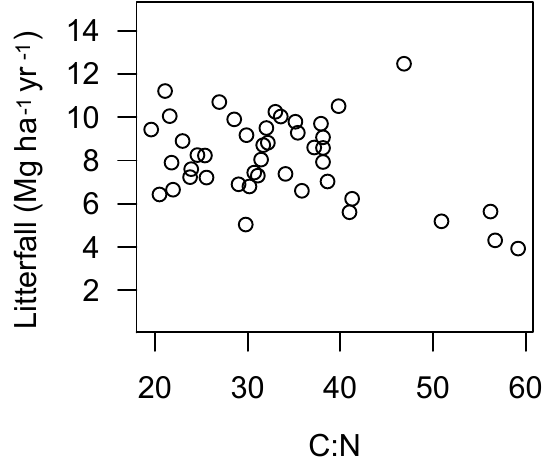
Fig. 7. Litterfall seasonality index SL (see Methods) in different forest types. The notations are the same as in Fig. 2.